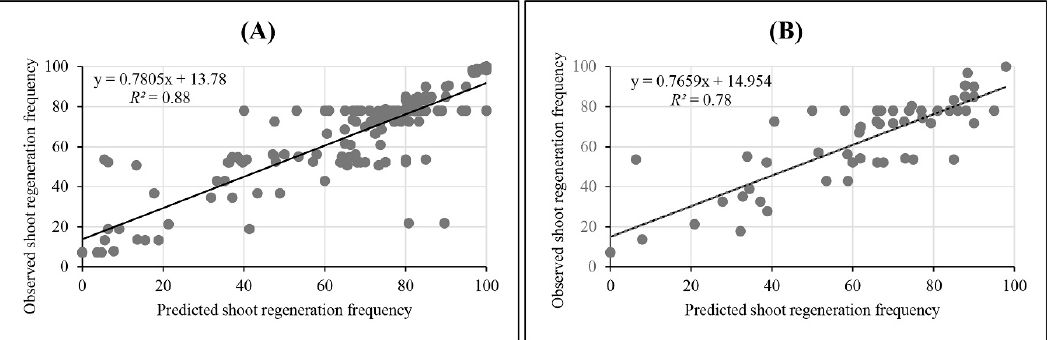
Figure 3. Experimental observed data against GRNN predicted outcomes of wheat in vitro shoot regeneration in training set ( A ) and in validation set ( B ).